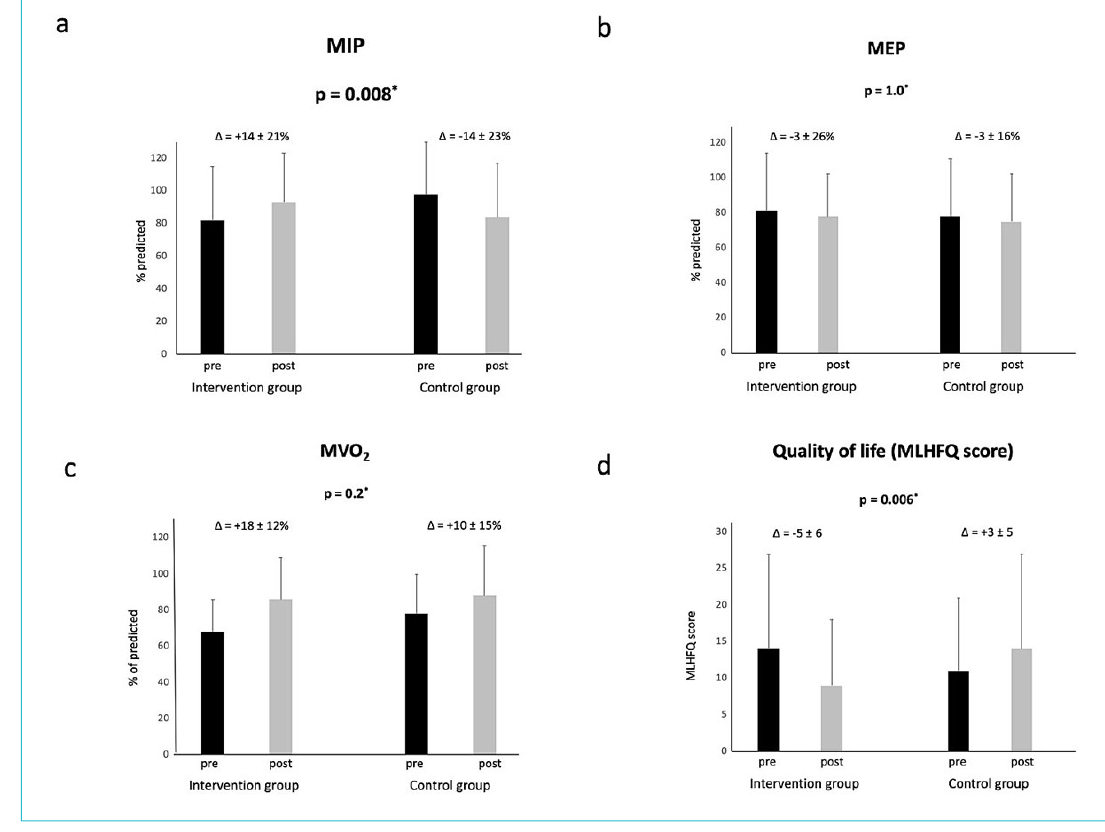
Figure 2: Primary and secondary endpoints. The figure shows the results at baseline (black bar) and after 12 weeks (grey bar) in the interven- tion (left bars) and in the control group (right bars). * marks the p-value of the mean change between both groups. Panel A (primary endpoint):